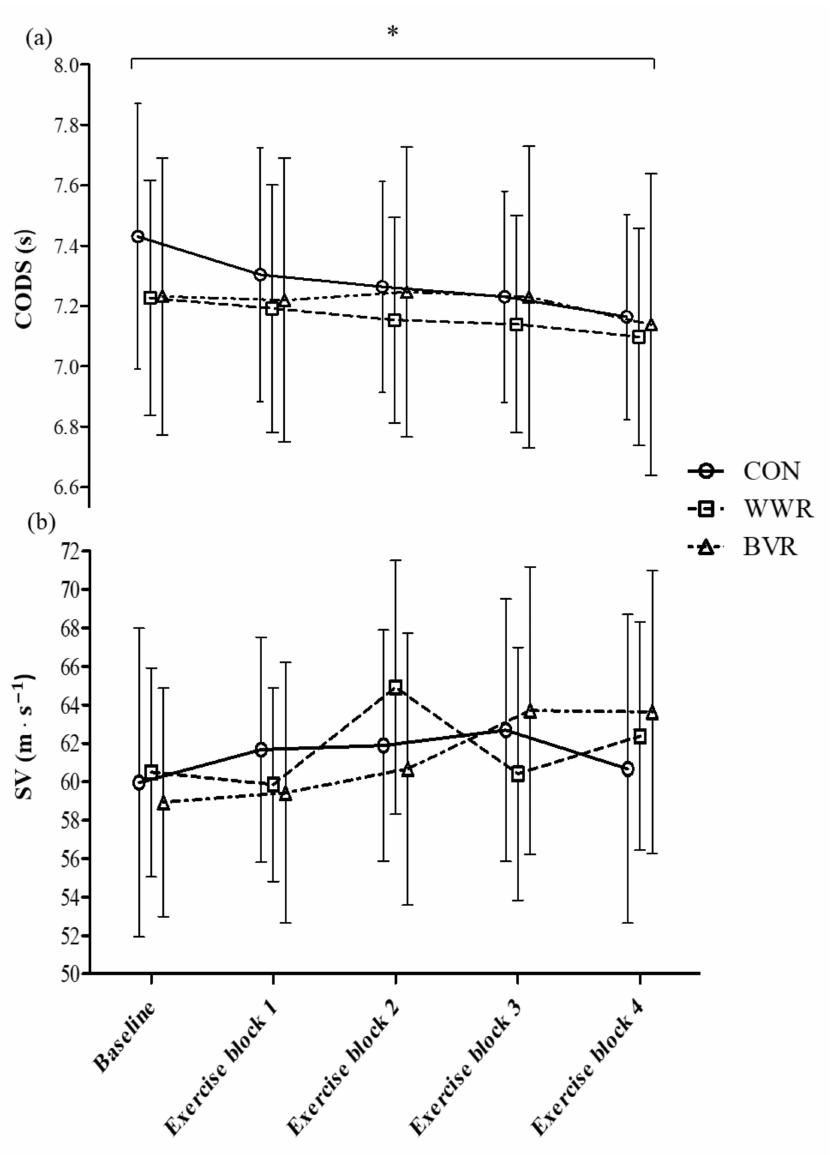
Figure 3. Change of direction speed (CODS) ( a ) and smash velocity (SV) ( b ) across all five timepoints. * Main effect of time p < 0.05, and post hoc tests revealed significantly faster CODS at exercise block 4 as compared to baseline and exercise block